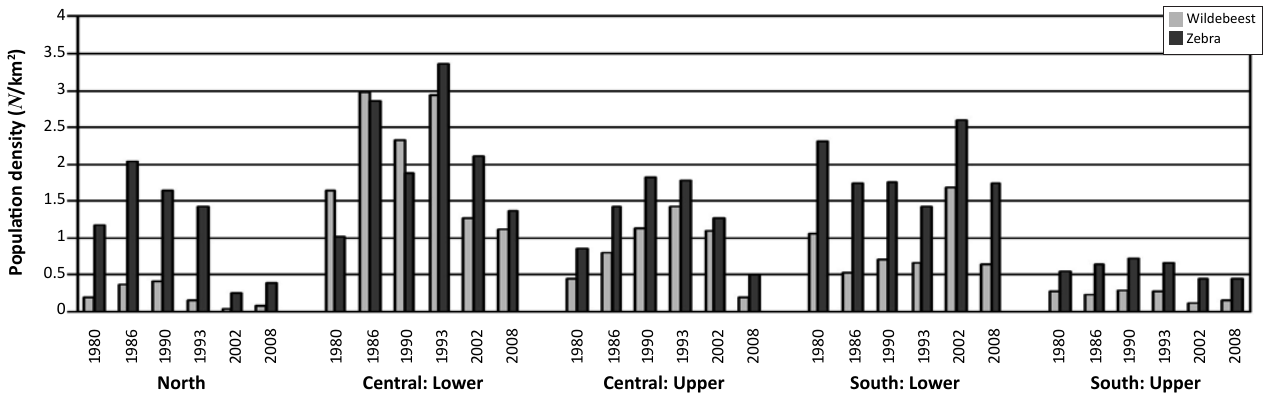
FIGURE 8: Population densities of blue wildebeest and zebra (1980–2008: Kruger National Park), differentiated according to subregions of divergent metabolic mode settings (CVRM-1).